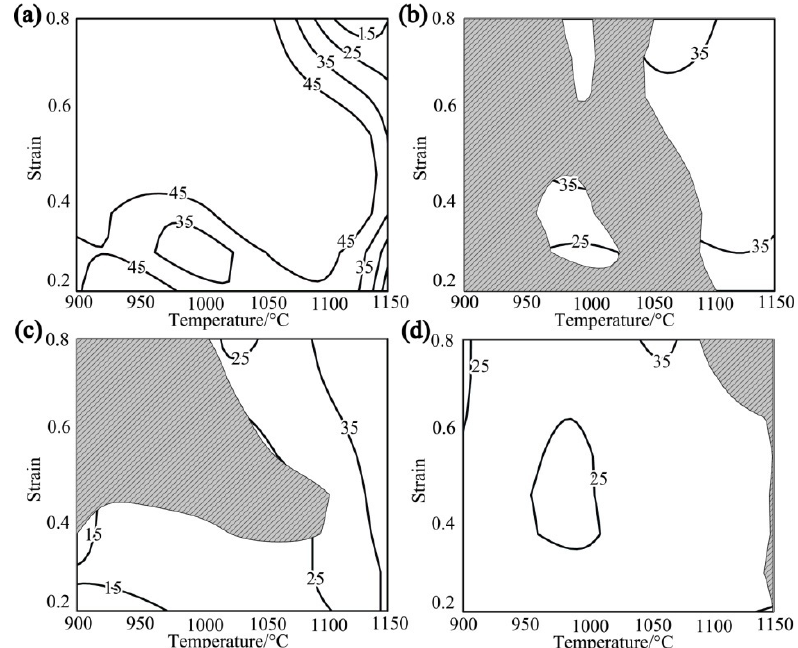
Figure 9. Hot working maps of 300M steel at the strain of ( a ) 0.2, ( b ) 0.4, ( c ) 0.6, and ( d ) 0.8.